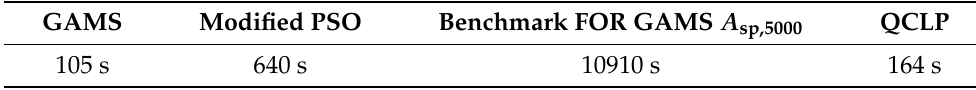
Table 2. Computation time of the different optimization